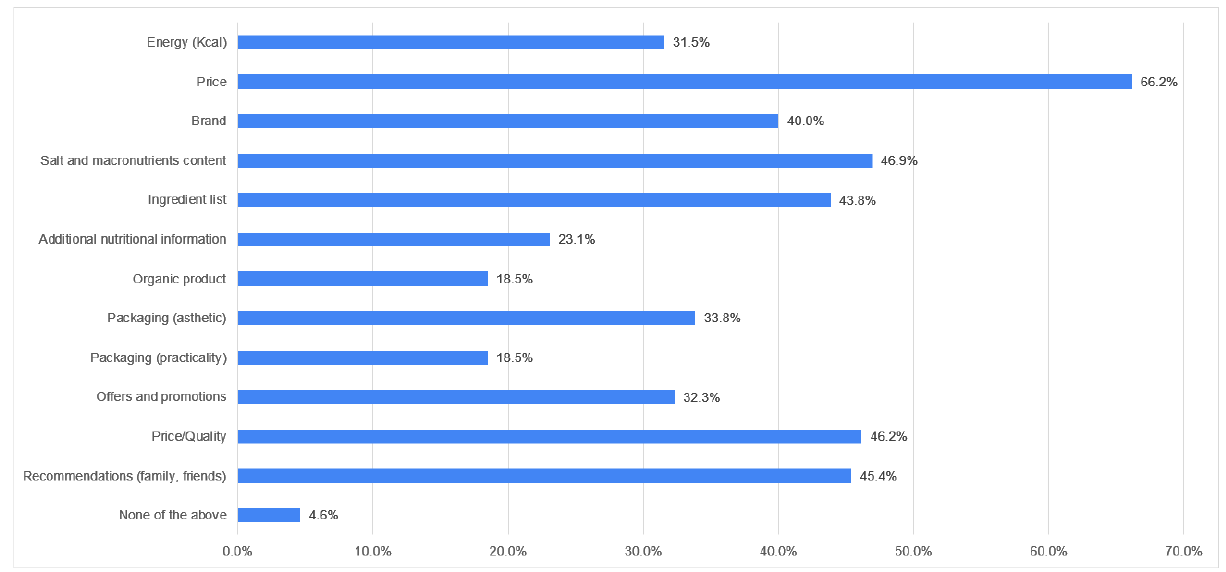
Figure 1. Influencing factors when buying a snack.